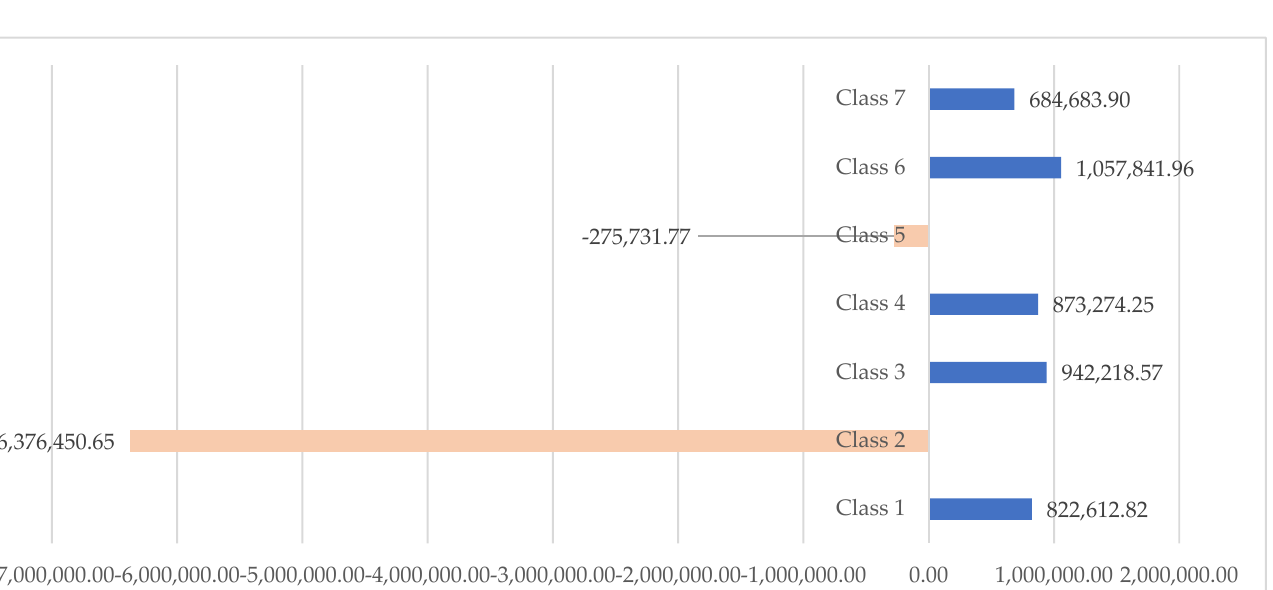
Figure 1. Histogram representation of the distribution of achievements on the Turnover of Top 50 companies in Galati (€). Source: Authors’ processing based on the information provided on Topfirme.com. Accessed date: 5 June 2018.